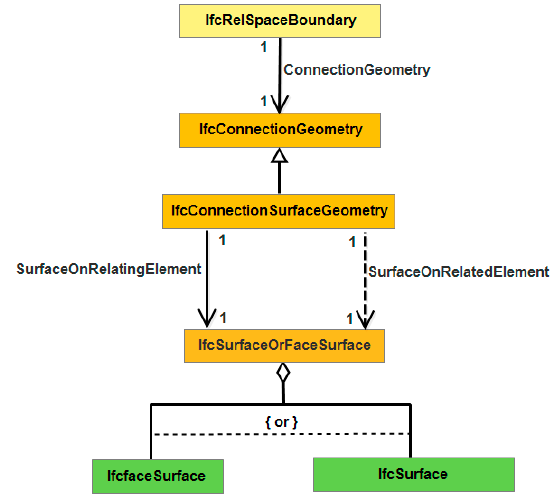
Figure 5. Geometric modelling of ownership boundaries in IFC.